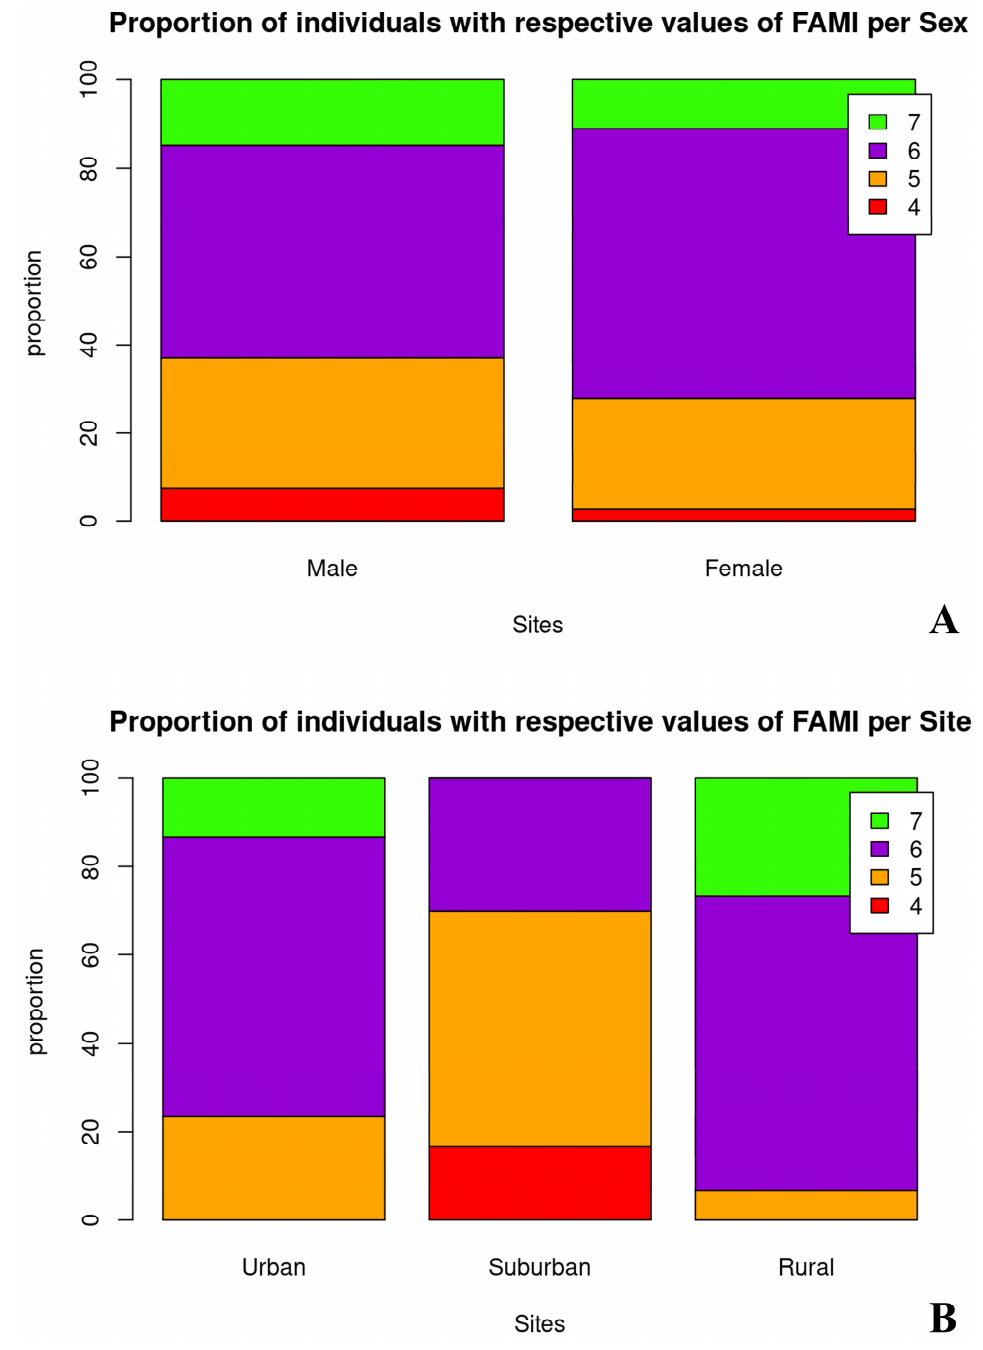
Figure 4. Proportion of individuals with respective FAMI values by sexes ( A ) and by sites ( B ). The individuals are grouped according to the number of the morphological characters with asymmetries observed, indicated with different colors shown in the legend.